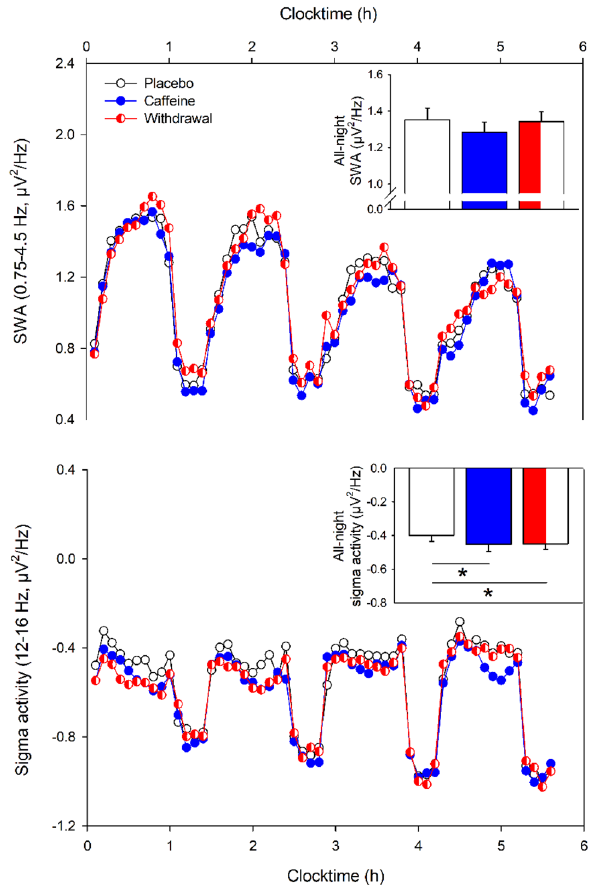
Figure 2. Temporal dynamics of SWA (top) and sigma activity (bottom) during the first four sleep cycles in the placebo (black open circles), caffeine (blue filled circles), and the withdrawal (red semi-filled circles) condition (mean values). The x-axis indicates the mean time of day. While SWA (0.75–4.5 Hz) was not significantly affected by the treatment, sigma activity (12–16 Hz) showed reduced activity during both caffeine and withdrawal compared to the placebo condition ( p all < 0.05). The inset in each right upper corner represents the mean values ± standard errors of the all-night SWA and sigma activity respectively during NREM sleep in the placebo, caffeine, and withdrawal condition. While all-night SWA (0.75–4.5 Hz) did not differ among the conditions, sigma activity (12–16 Hz) was lower in the caffeine and withdrawal condition compared to placebo ( p < 0.05). All analyses are based on log-transformed